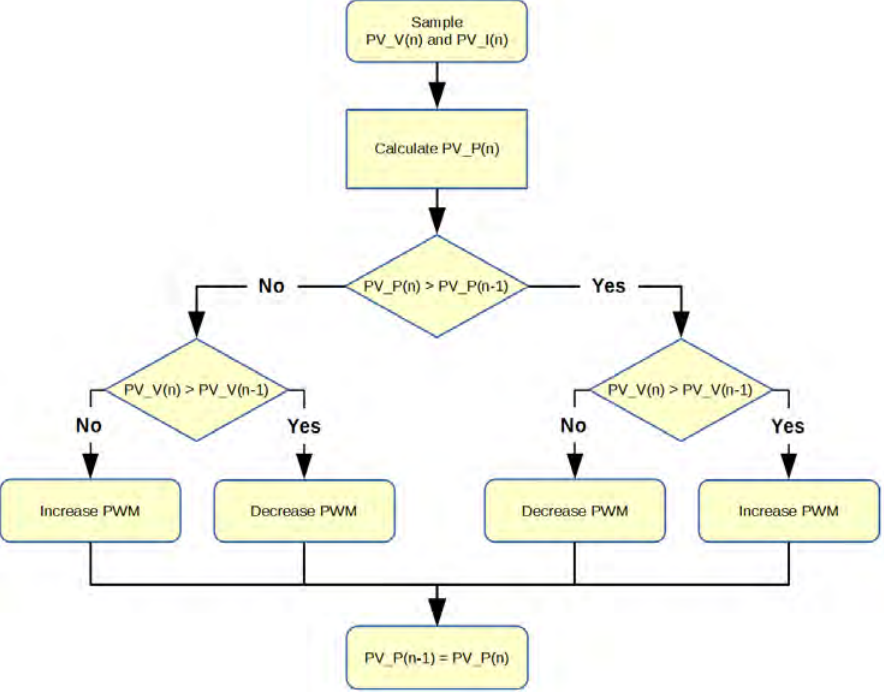
Figure 6. Perturb and Observe MPPT